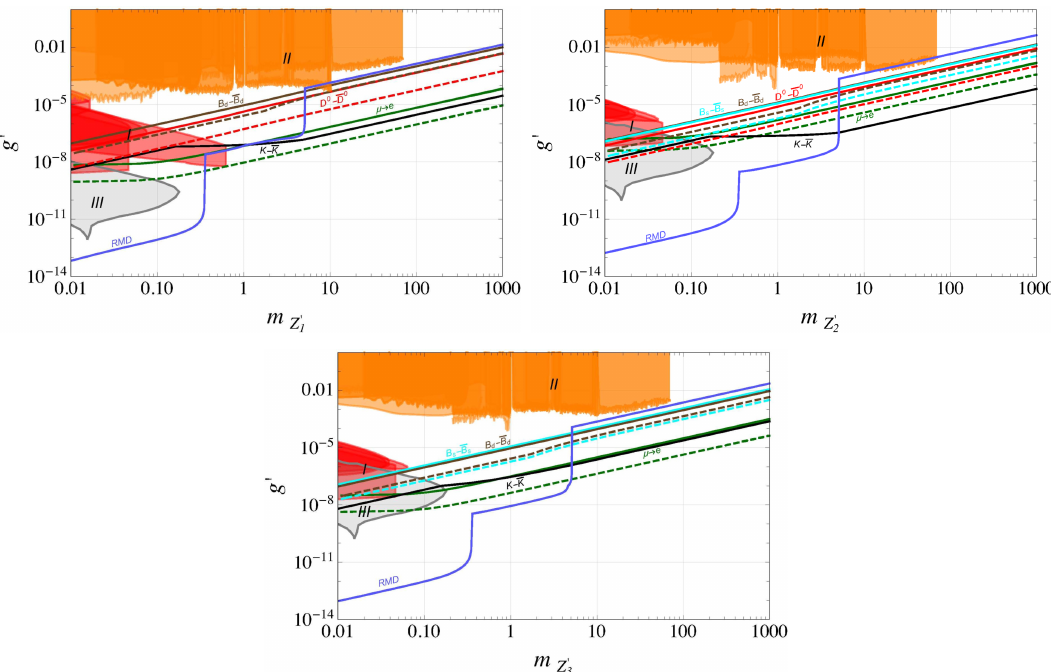
Figure 3 . The strongest bounds on the parameter space for the Z 0 Z 0 (bottom) gauge bosons in the U(1) 3 3